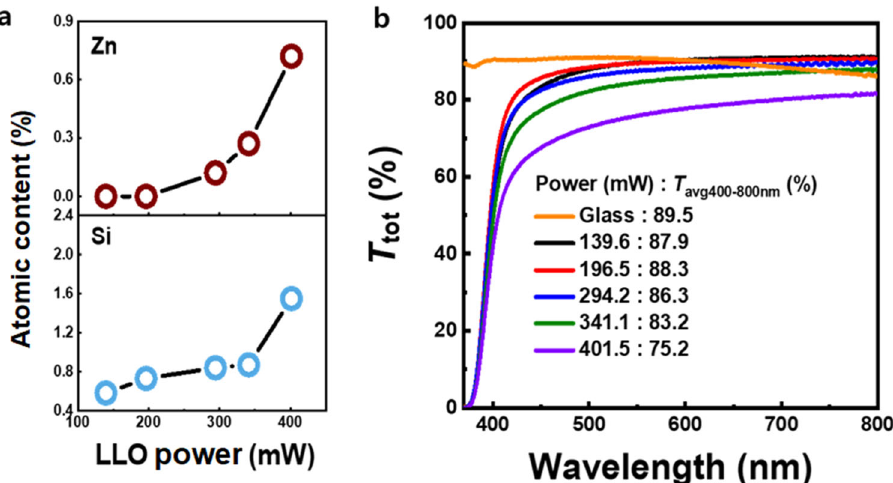
Fig. 2 Film quality with laser lift-off (LLO) power. Effects of LLO power on a residual Si and Zn contents and b total transmittance curves of CPI fi